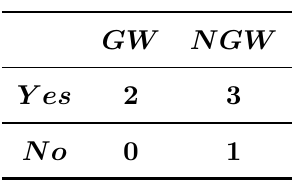
Table 2. Payoffs to